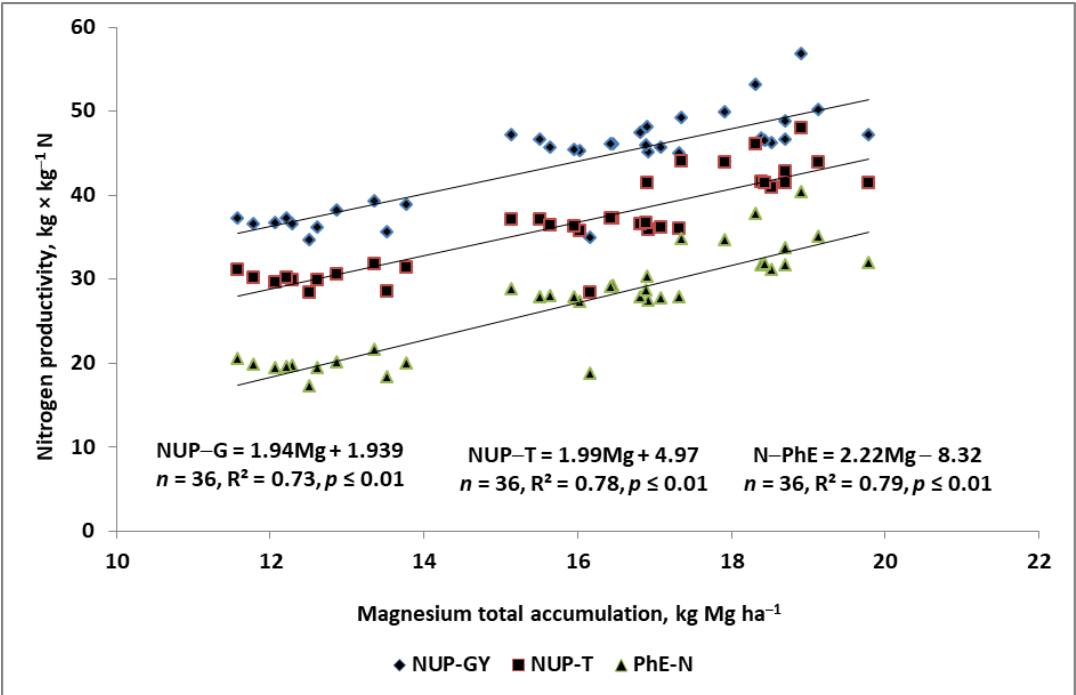
Figure A4. Effect of magnesium total accumulation in winter wheat on indices of nitrogen utilization. Legend: NUP-G and NUP-T — nitrogen unit productivity: grain and total, respectively; N-PhE — nitrogen physiological efficiency.